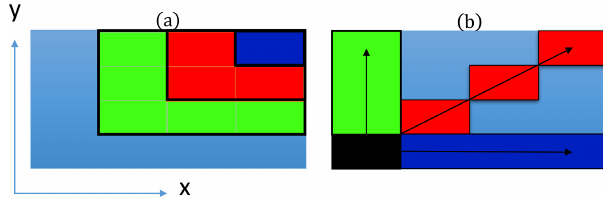
Figure 6. Illustration of the wall-normal plane decomposed into 16 equal-sized rectangles. Panel (a) shows how the sampling region is varied by size; the dark blue rectangle is an example of A 1 , the red rectangle is for A 4 , and green shows A 9 . Panel (b) illustrates the varying directional coverage with a fixed area A 4 . The minimum rectangular unit covers 3.1km 2 , or 1 / 16 of the horizontal domain